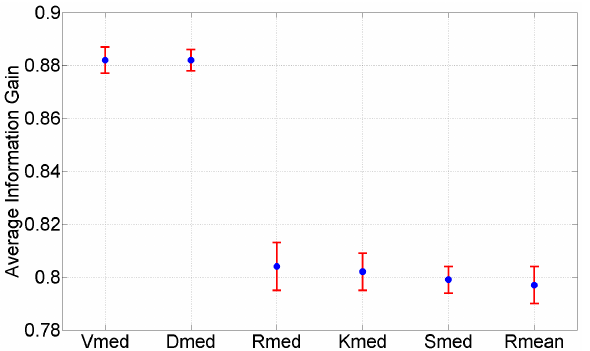
Figure 1: Average information gain per metric using stratified cross validation with 10 folds. The standard deviations between folds are represented as vertical red bars.